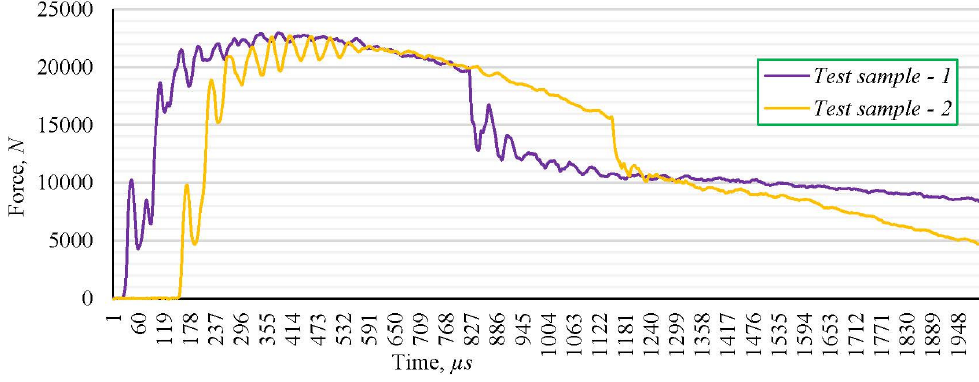
Figure 6. Force-time dependence during the impact toughness testing of the parent metal.